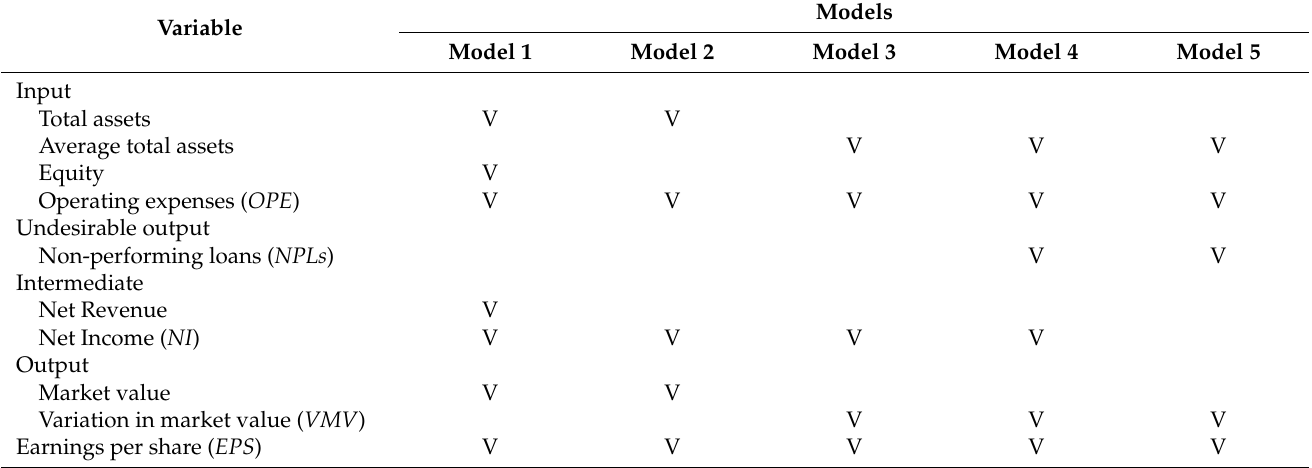
Table 4. Variables specification of Models 1–4.